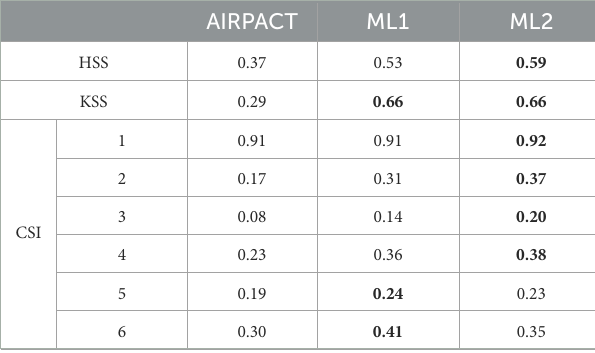
TABLE 6 Forecast verifications of the 10-time, 10-fold cross-validations using AQI computed with only PM2.5 during wildfire season from AIRPACT and our ML